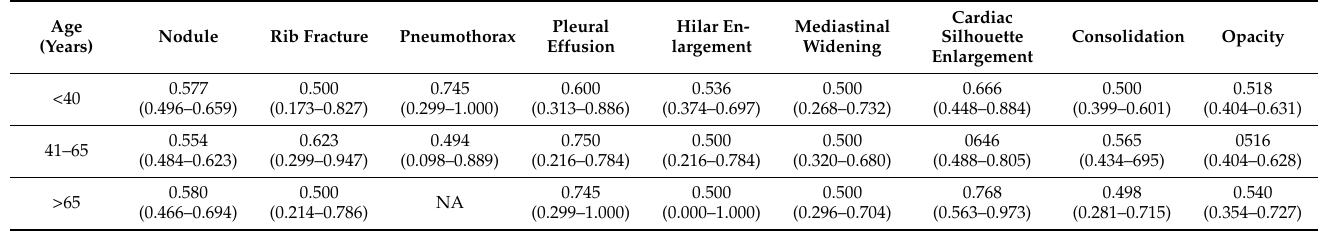
Table 6. Variations in the AI algorithm’s performance for detecting different radiographic findings based on age group (female versus male patients). Table represents area under the curve with 95% confidence intervals in parentheses. (Key: NA—not applicable because there was no missed pneumothorax in patients over 65